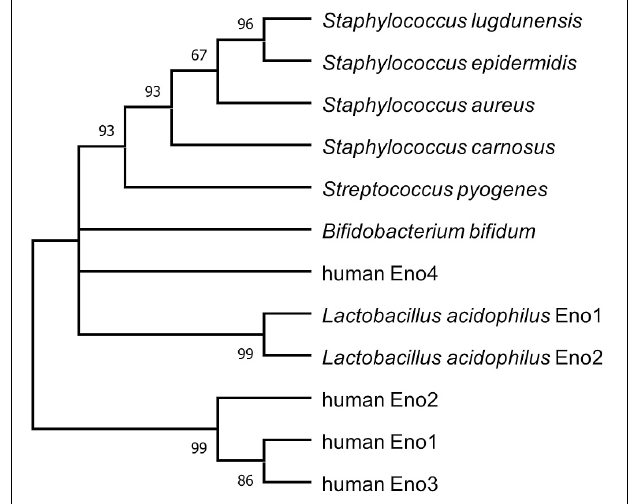
FIGURE 2 | Bootstrap consensus tree inferring molecular phylogenetic of enolase. The maximum likelihood analysis was used to infer the evolutionary relationship for enolases of selected species (Le and Gascuel, 2008). Branches corresponding to partitions reproduced in less than 50% bootstrap replicates are collapsed. The percentage of replicate trees in which the associated taxa clustered together in the bootstrap test (1,000 replicates) are shown next to the branches (Felsenstein, 1985). This analysis involved 12 amino acid sequences. There were a total of 638 positions in the final dataset. Evolutionary analyses were conducted in MEGA X (Kumar et al.,